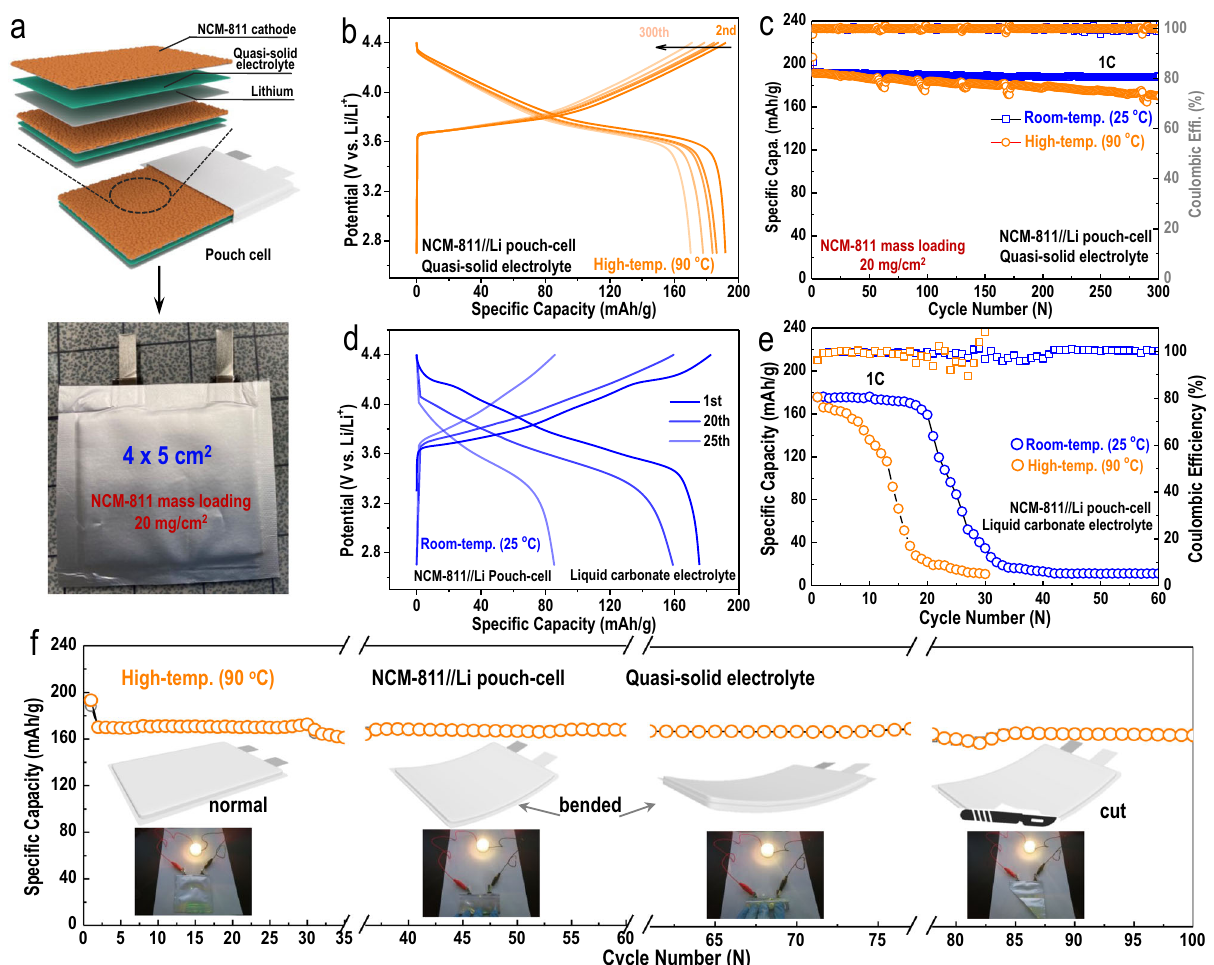
Fig. 6 NCM-811//Li pouch cells used a quasi-solid electrolyte under harsh working conditions. a Schematic illustration of the cell structure and digital photo of an NCM-811//Li pouch cell assembled with a MOF-based quasi-solid electrolyte. b Discharge/charge curves and c the corresponding cycling performances of the NCM-811//Li pouch cell assembled with a quasi-solid electrolyte under a high cathode mass loading (approximately 20 mg cm − 2 ) and at high temperature of 90 °C (yellow curve). The blue curve represents the cycling performance obtained at room temperature (25 °C). d Discharge/ charge curves and e the corresponding cycling performances of the NCM-811//Li pouch cell assembled with a typical liquid electrolyte under a high cathode mass loading (~20 mg cm − 2 ) and room temperature of 25 °C (blue curve). The yellow curve represents the cycling performance obtained at a high temperature of 90 °C. f Cycling performance of an NCM-811//Li pouch cell (NCM-811 cathode mass loading approximately 20 mg cm − 2 ) assembled with a MOF-based quasi-solid electrolyte under a harsh working environment of high working temperature (90 °C) and after sustaining damage (bent and